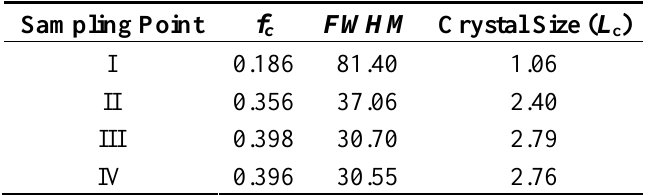
Table 2. Orientation and crystallite size for fibers spun into a 57.8 wt% DMAc/H 2 O coagulation bath obtained from WAXD.